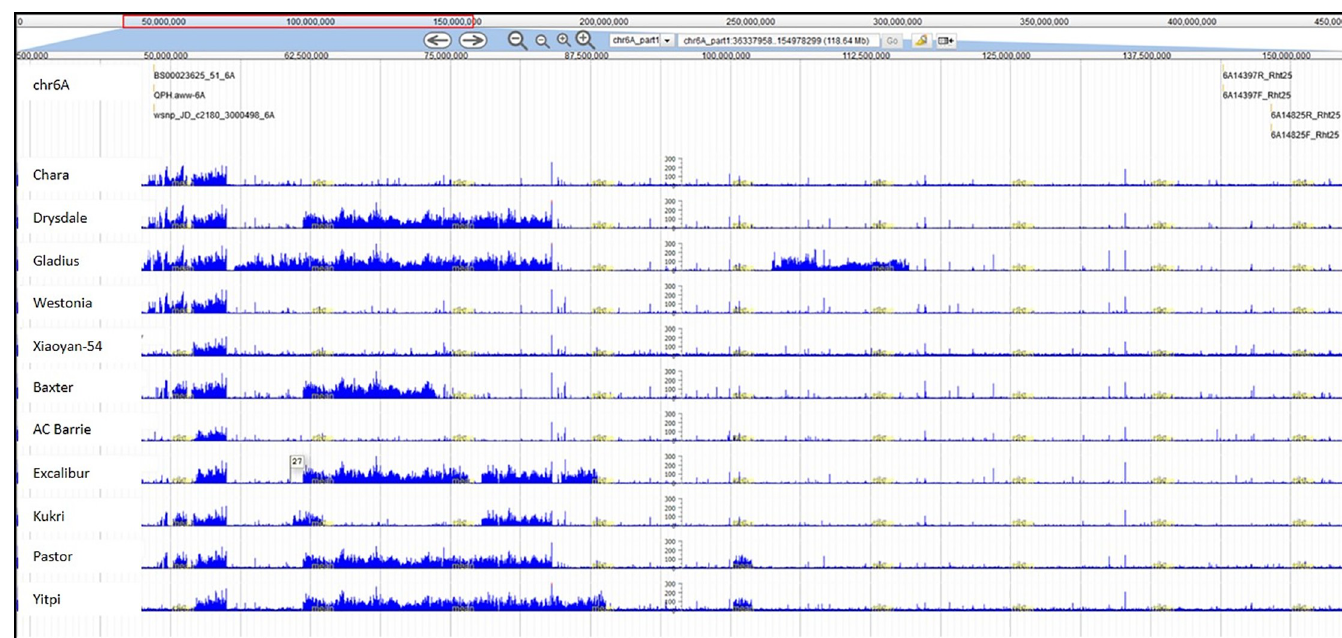
Fig 5. DAWN screenshot of chromosome 6A region containing QPh . aww-6A and Rht-25 loci on Chinese Spring RefSeq v1.0. The “Genes” track shows the high confidence genes according to the RefSeq annotation v 1.0. The blue tracks show the variant density (SNP per 10 Kb–log scaled) in comparison to RefSeq v1.0 for 11 wheat accessions; the different profiles across this region indicates that QPh . aww-6A and Rht-25 segregate independently.